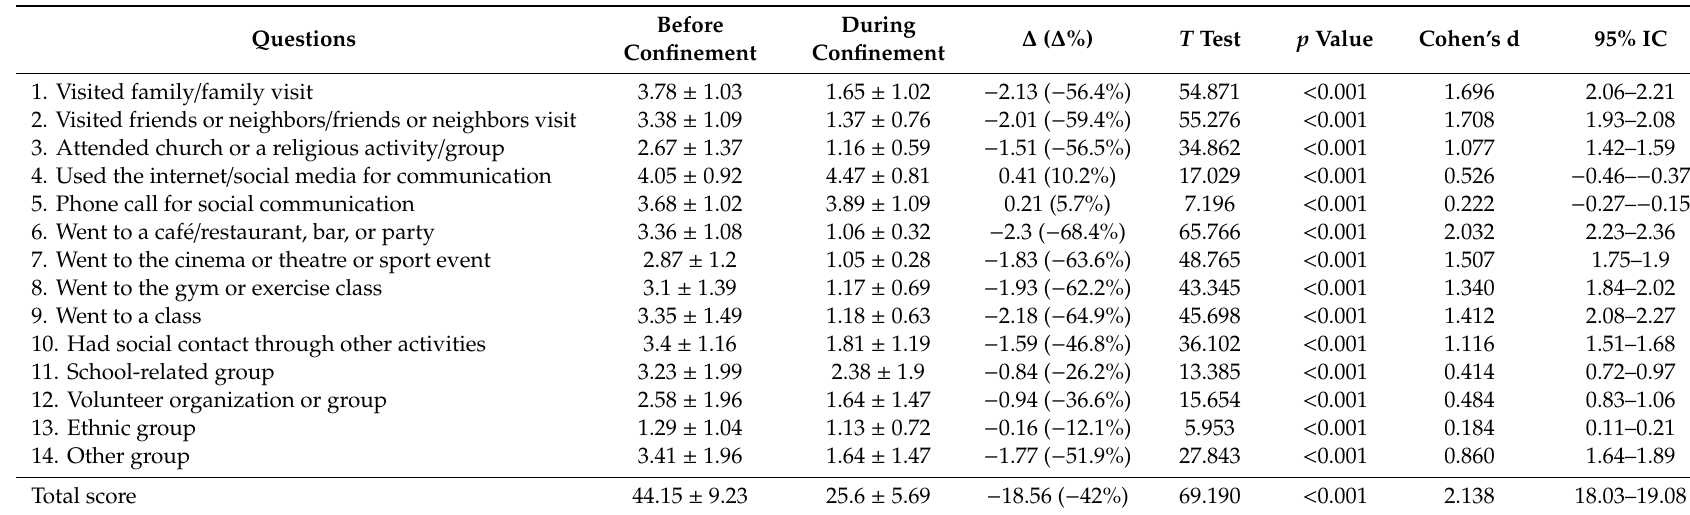
Table 2. Responses to Short Social Participation Questionnaire—Lockdowns (SSPQL)before and during home confinement.